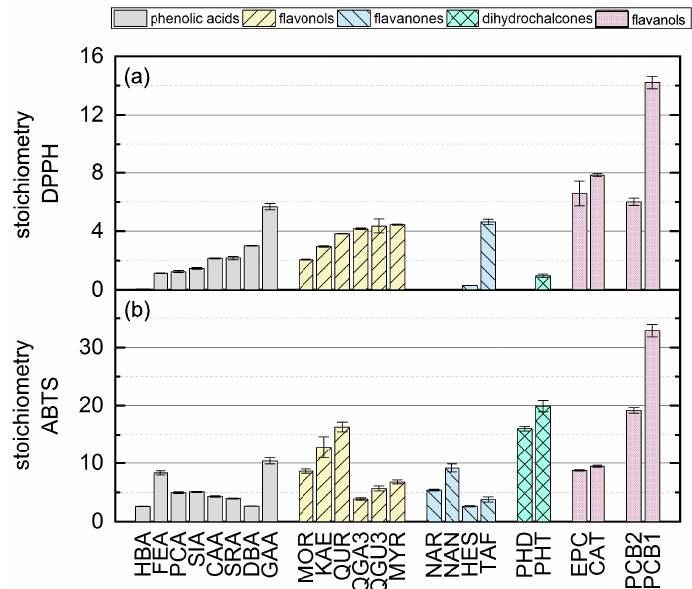
Figure 7. The antioxidant activity of all standard references in the ( a ) DPPH and ( b ) ABTS assays. Data are mean values of three measurements and standard